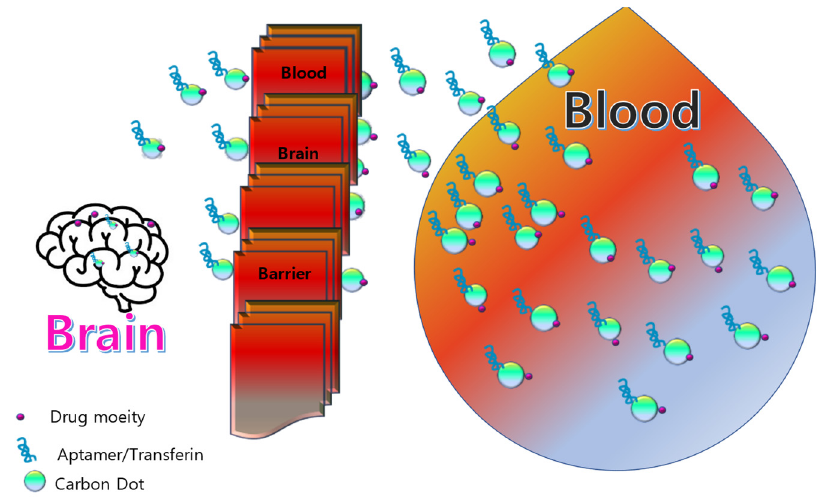
Figure 4. Schematic representation of CDs as promising nano carrier for drug delivery across blood brain barrier